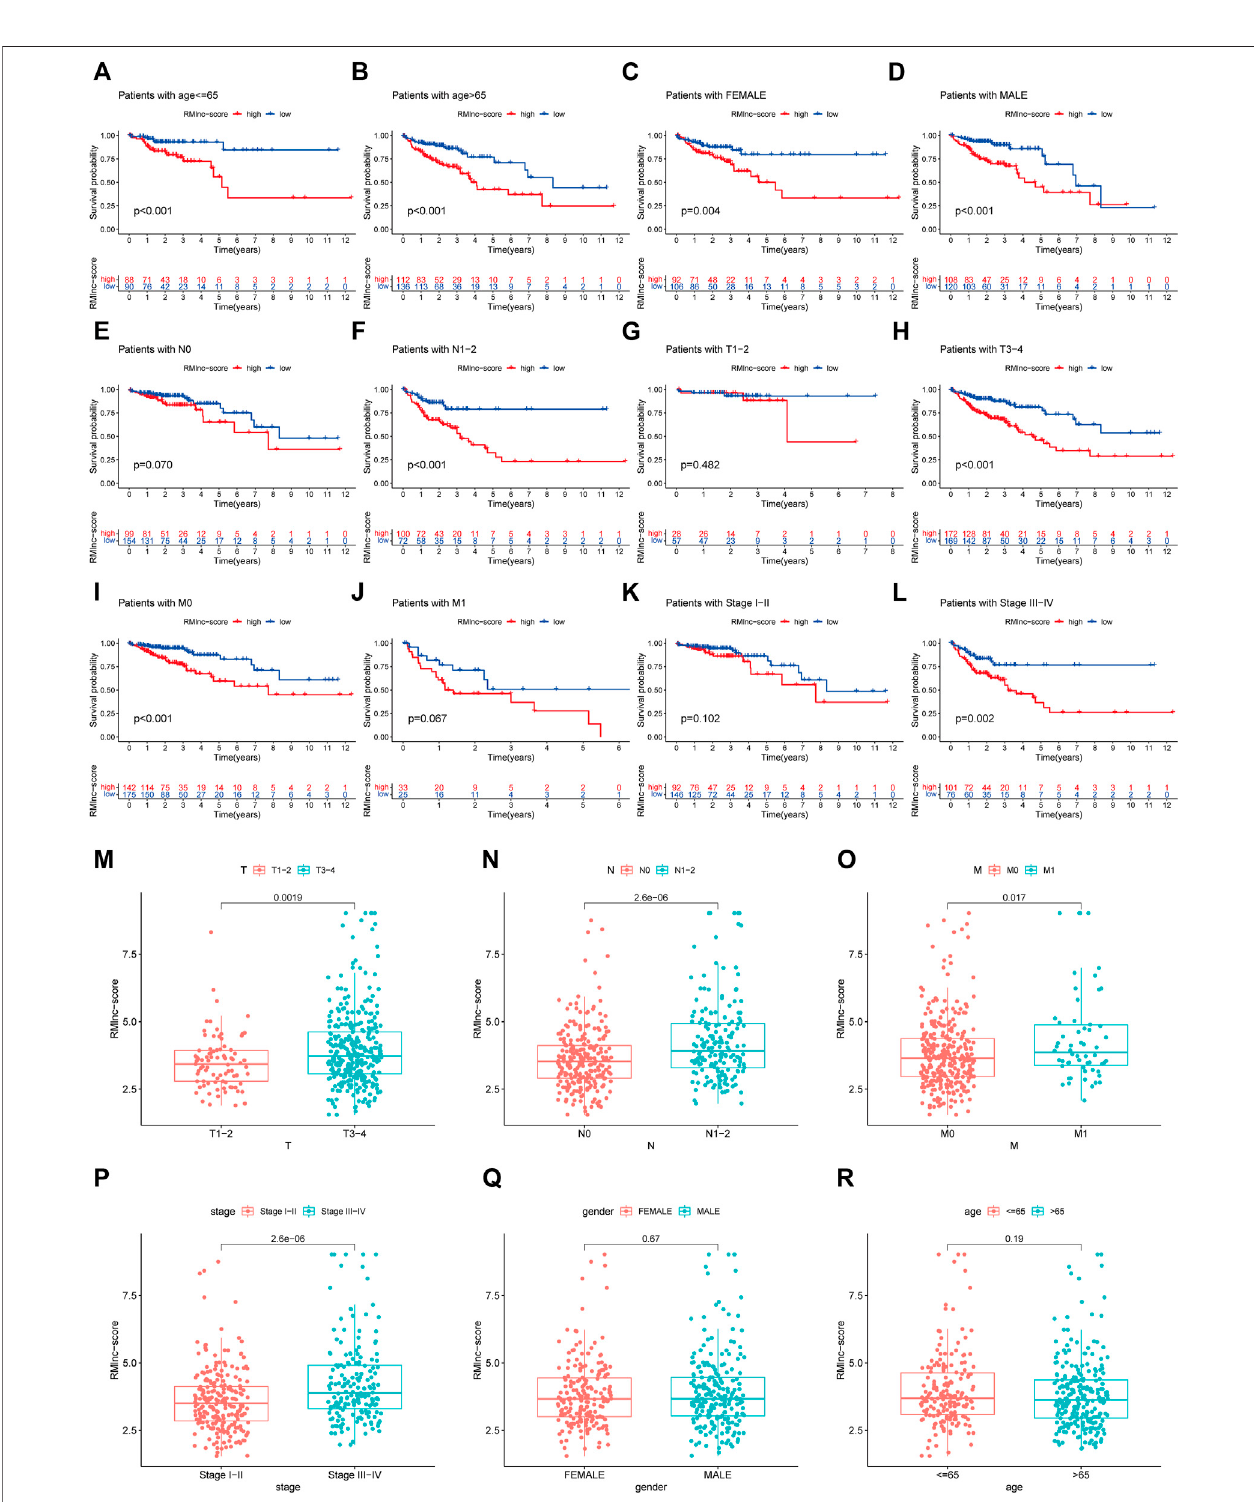
FIGURE 8 | Correlation of clinical characteristics with RMlnc-score by subgroup analysis. Kaplan-Meier curves strati fi ed by (A,B) age, (C,D) sex, (E,F) N stage, (G,H) T stage, (I,J) M stage, and (K,L) clinical stage. (M – R) Differential analysis of RMlnc-score for different subgroups.